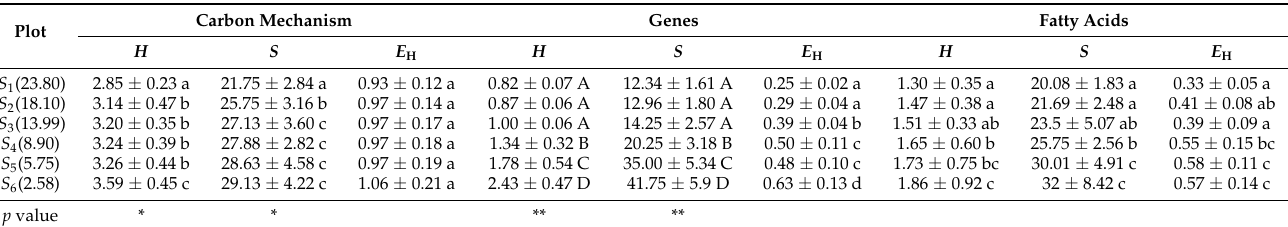
Table 3. Changes in the soil bacterial diversity indexes due to the salinity levels (n = 5, Mean ± SE). Carbon Mechanism Genes Fatty Acids Plot